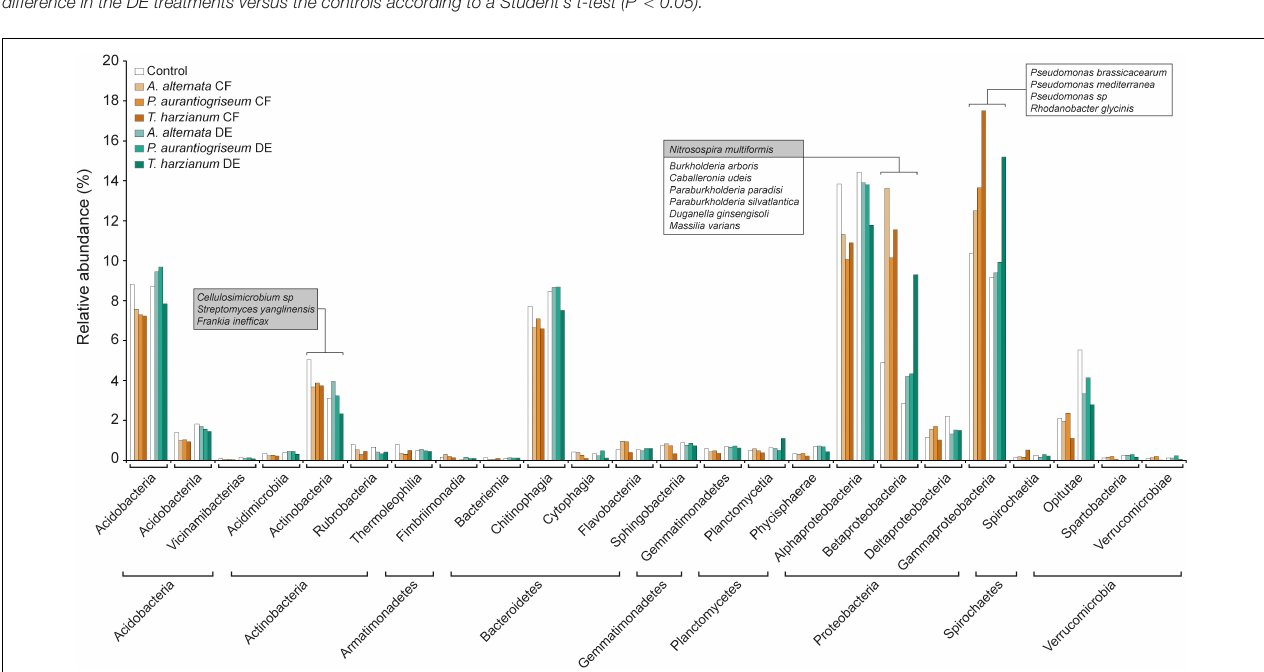
FIGURE 3 | Soil application of fungal CFs and DEs alters the composition of the soil bacterial microbiota. The figure shows the relative abundances of bacteria in soils irrigated with fungal CFs (highlighted in brown) and DEs (highlighted in green). Relative abundances of bacteria in control soils are shown in white bars. Bacteria were arranged according to their phylum and class. Species discussed here whose relative abundances are significantly altered by the CF and DE treatments are boxed. Names of species enriched and impoverished by soil application of CFs and DEs are included in white and gray boxes, respectively. Data obtained from Supplementary Table 4